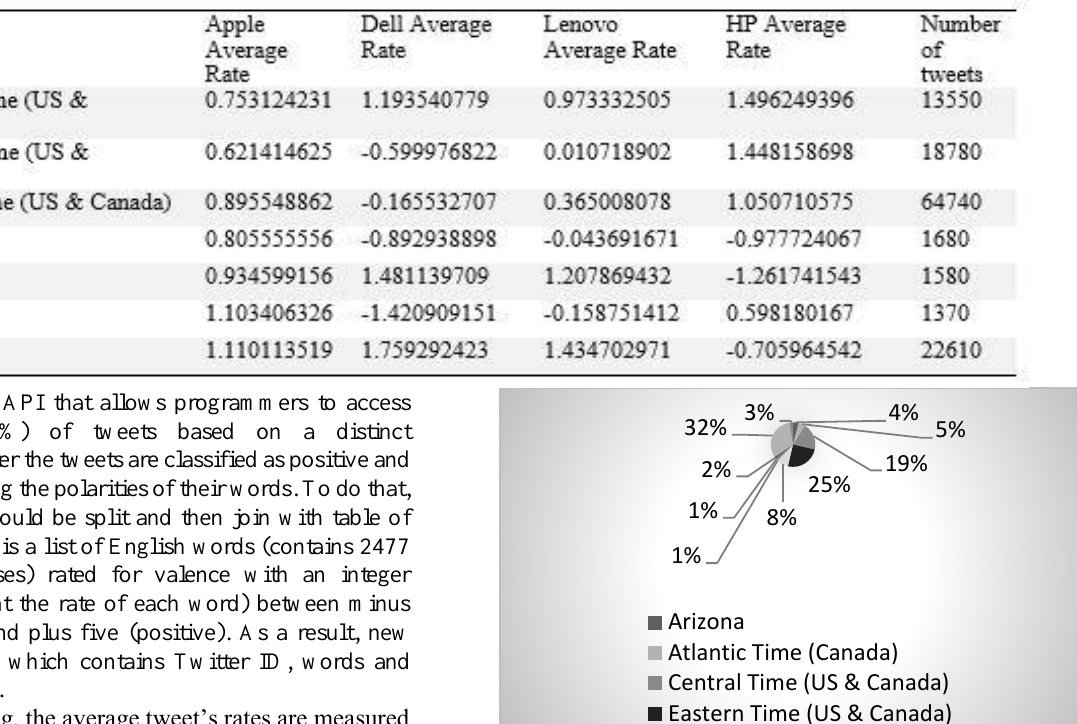
Table 1. People opinion about 4 laptop brands in 8